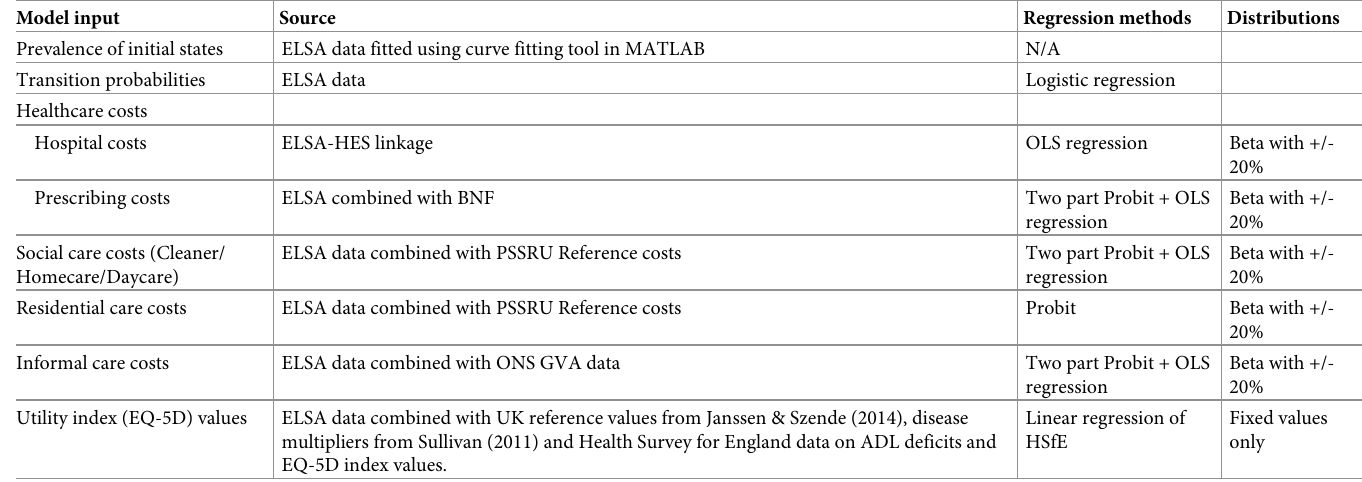
Table 1. Summary of model inputs, with data sources, regression methods and distributions. Full regression equations are shown in Appendices 1 and 2 in S1